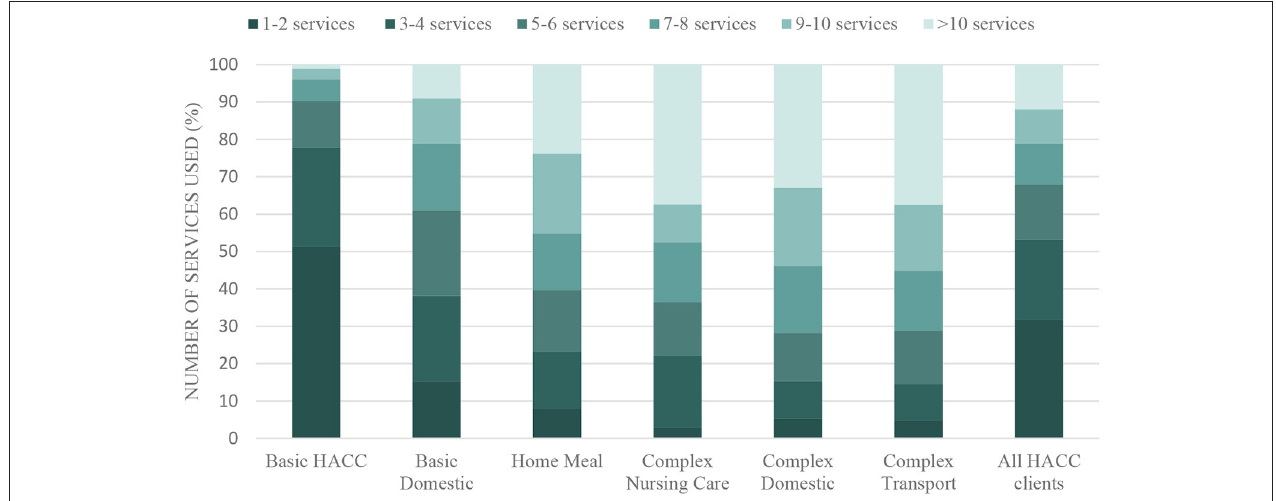
FIGURE 2 | Number of HACC services used by women in different service clusters over the period July 2001 to December 2011. Adapted by permission from Rahman et al. ( 24).